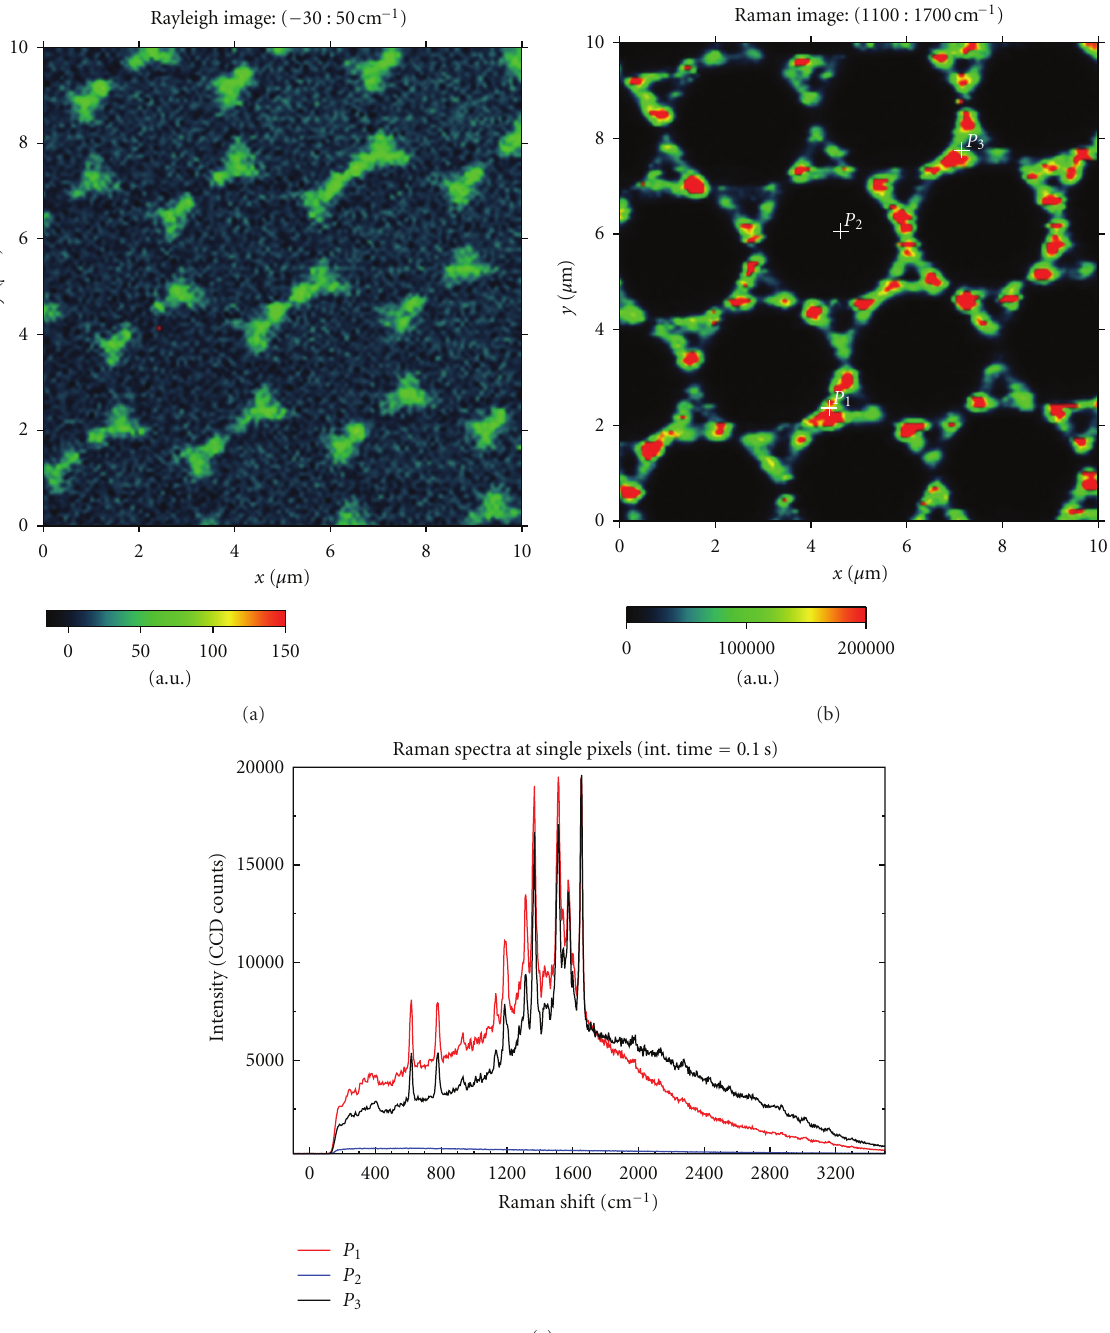
Figure 5: SERS of rhodamine 6G molecules on silver patterns of 3 μ m diameter and 50nm thickness. λ = 532nm. P exc = 15 μ W. The spectra below were extracted from the pixels marked. Whereas for point P 2 only background was detected, at the edge of triangular particles, strong SERS spectra of R6G were measured ( P 1 and P 3